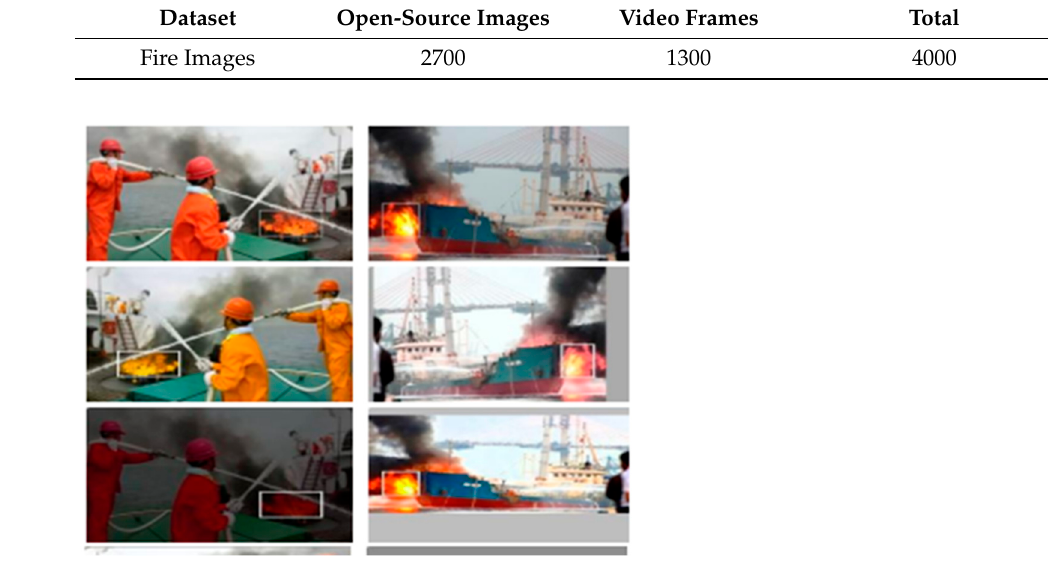
Figure 1. Example fi re dataset